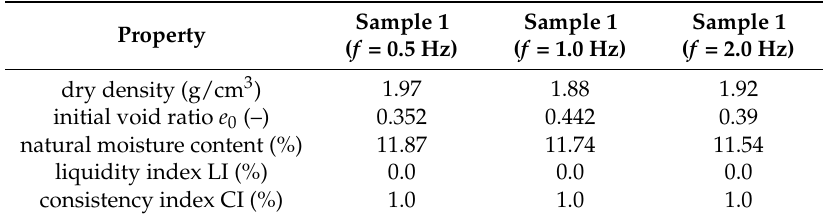
Table 1. Physical properties of tested soil in cyclic triaxial